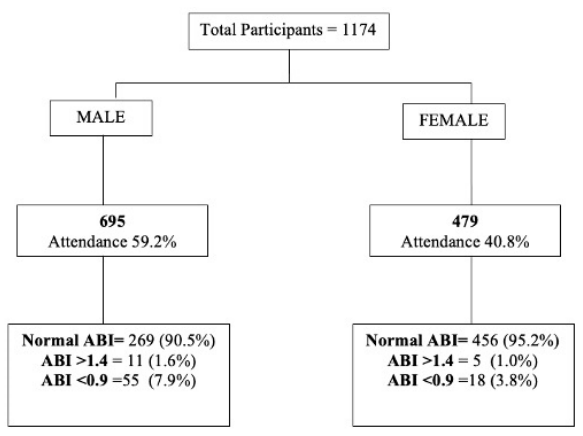
Figure 2. Flowchart screening